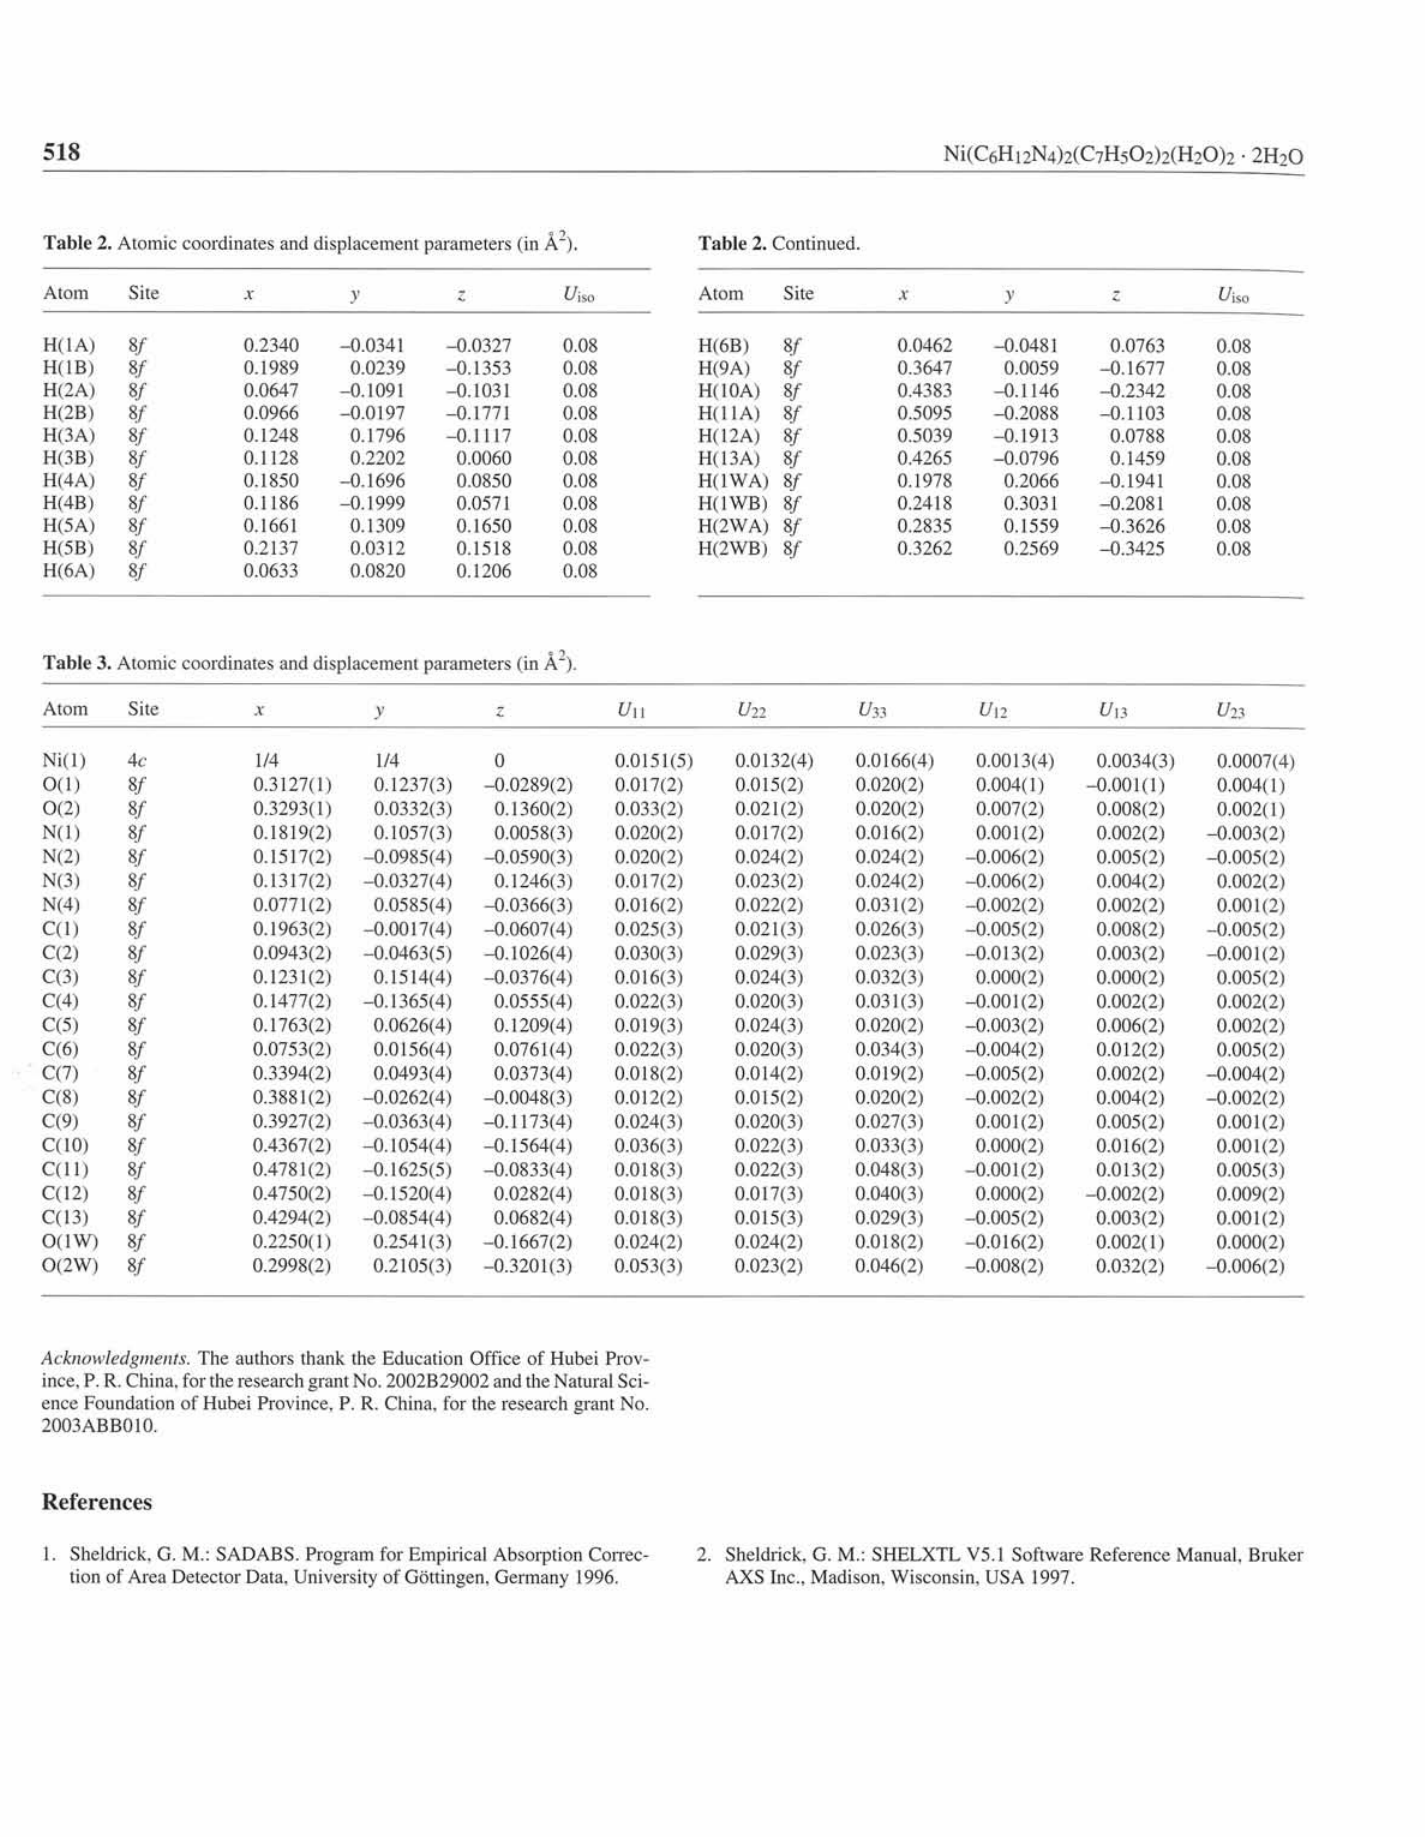
Table 2. Atomic coordinates and displacement parameters (in À 2 ). Table 2. Continued.